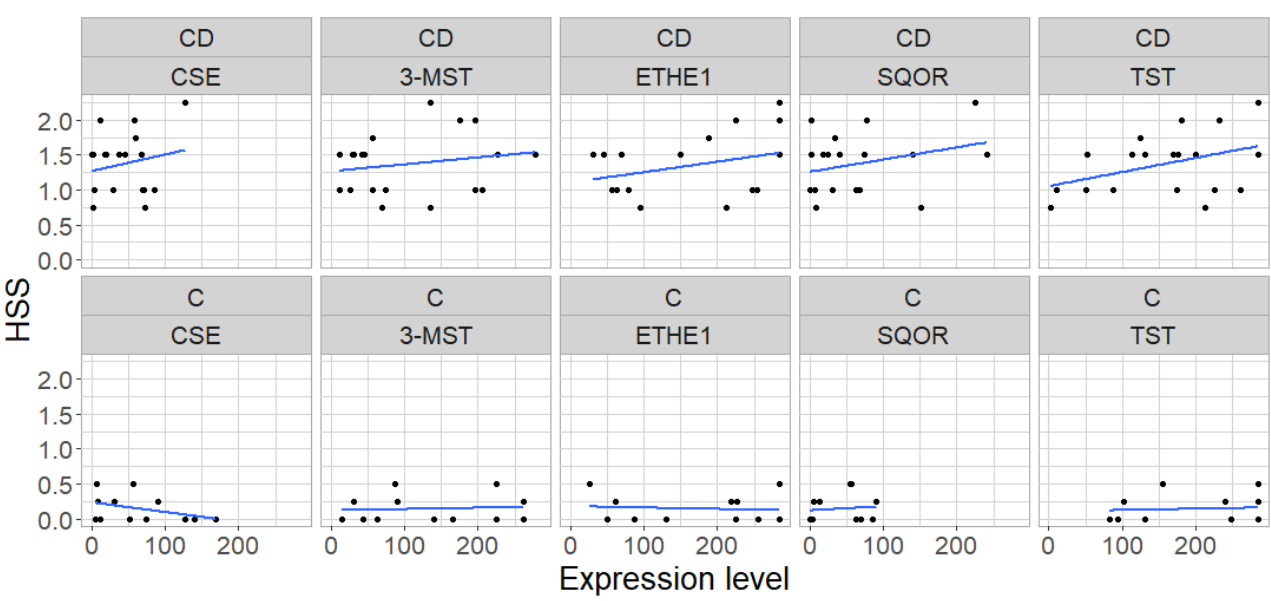
Figure A1. Expression levels of cystathionine- γ -lyase (CSE), 3-mercapto-sulfurtransferase (3-MST), ethylmalonic encephalopathy 1 protein (ETHE1), Sulfide:quinone oxidoreductase (SQOR) and thiosulfate sulfurtransferase (TST) of biopsies from the terminal ileum compared to the histologic severity score (HSS) of each sample, separated into Crohn’s disease (CD) and controls (C).